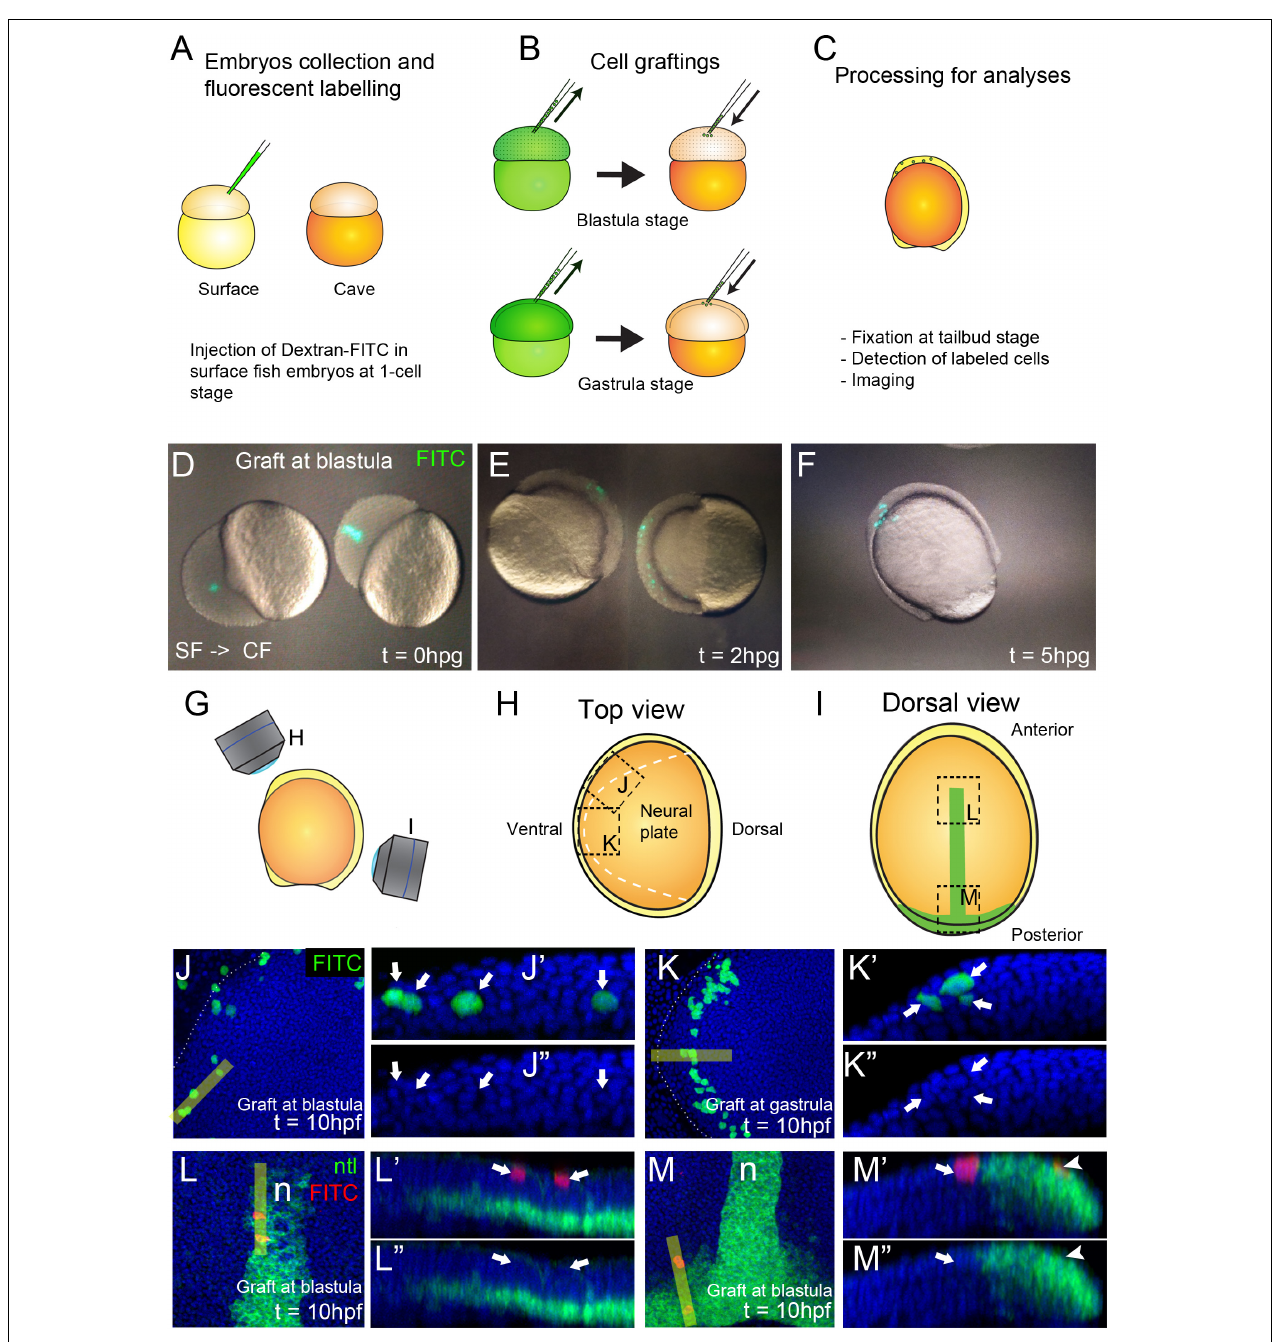
FIGURE 4 | Generation of chimeric embryos in A. mexicanus by inter-morph cell transplantation. Procedure for cell grafting between surface and cavefish embryos (A–C) . Live cavefish (host) embryos that have been transplanted with FITC-labeled surface cells (green) at the blastula stage, photographed immediately after the grafting [0 hpg, (D) ], or after 2 hpg (E) and 5 hpg (F) . Fluorescent labeled embryos at tailbud stage were imaged in a confocal microscope in a view from the top (G,H) and from the dorsal side (G,I) . Black dashed lines indicate the orientation of the images shown in panels (J–M) . Dashed white line indicate the neural plate border (H,J,K) . Confocal images of dissected cavefish embryos at 10 hpf at the level of the anterior neural plate (J, K) . Labeling in green corresponds to surface fish cells grafted at blastula (J) and gastrula (K) stages. Respective reconstructed sections were obtained at the levels indicated in yellow bars and grafted cells are indicated with arrows (J (cid:48) ,J (cid:48)(cid:48) ,K (cid:48) ,K (cid:48)(cid:48) ) . Confocal images of dissected cavefish embryos at 10 hpf stained for ntl [green, (I,L,M) ], at the level of the anterior notochord (L) and the tail bud (M) . Labeling in red corresponds to surface fish cells grafted at blastula stage and labeling in greencorresponds to ntl expression in the notochord. Respective reconstructed sections were obtained at the levels indicated in yellow bars (L (cid:48) ,L (cid:48)(cid:48) ,M (cid:48) ,M (cid:48)(cid:48) ) . Arrows (L (cid:48) ,L (cid:48)(cid:48) ,M (cid:48) ,M (cid:48)(cid:48) ) indicate superficial ectodermal grafted cells. Arrowheads (M (cid:48) ,M (cid:48)(cid:48) ) indicate a cell in the mesodermal domain expressing ntl . Images in panels (J,K) are top views, anterior to the left. Panels (L,M) are dorsal views, anterior to the top. Reconstructions are oriented with anterior to the left and dorsal on top.